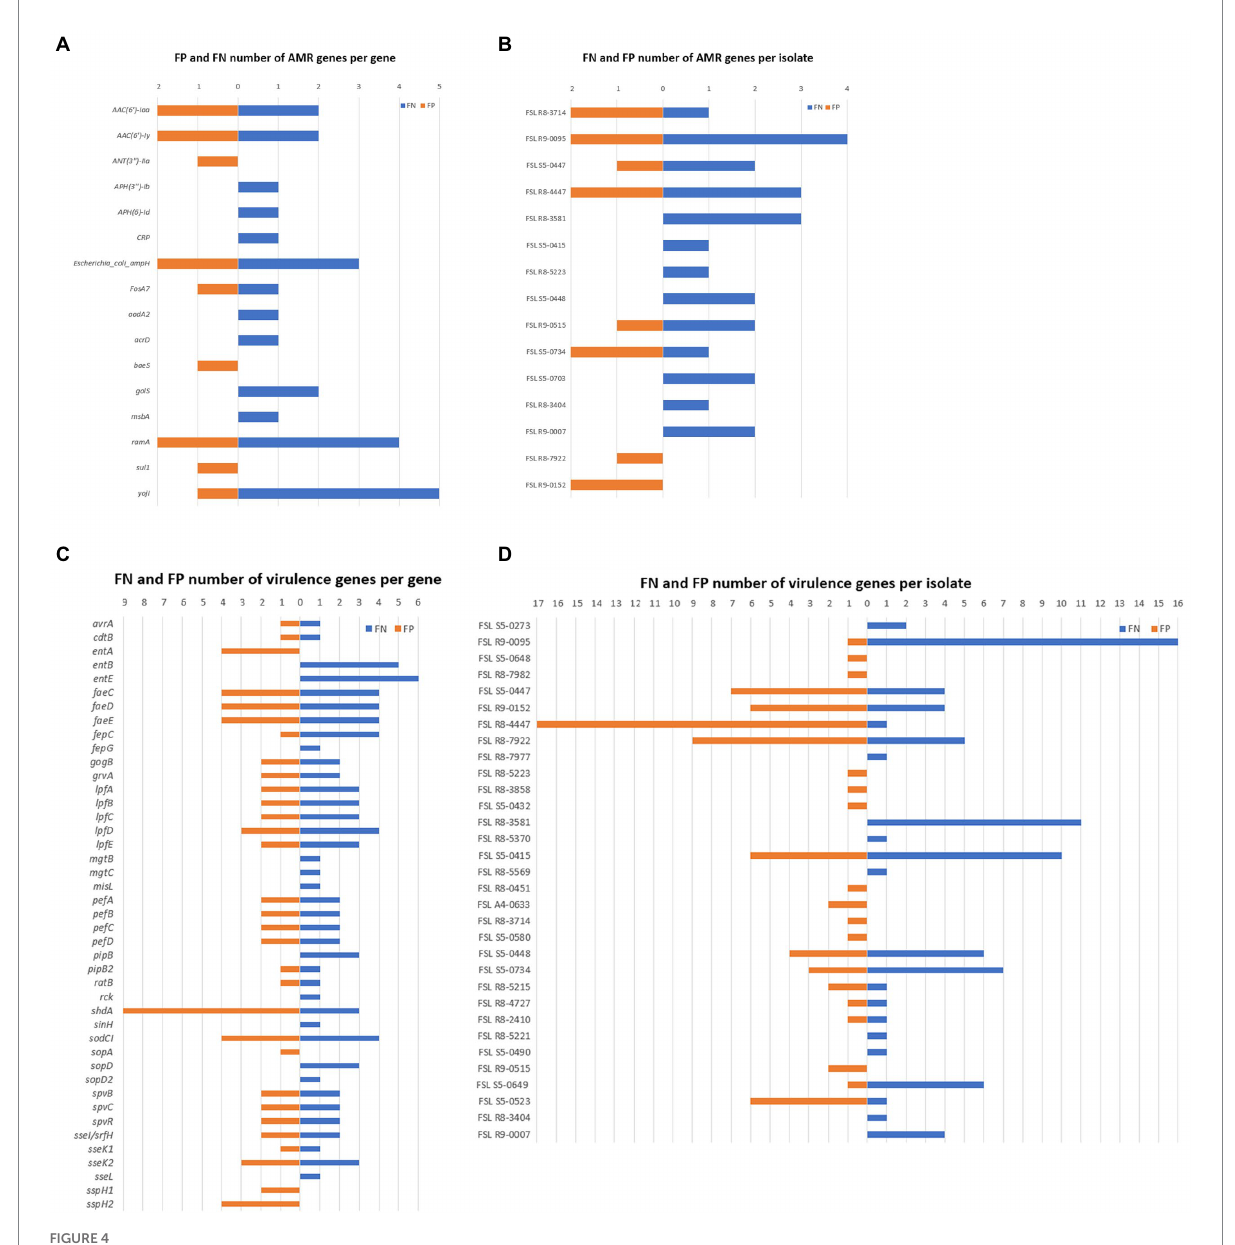
FIGURE 4 False Positive (FP) and False Negative (FN) numbers of AMR and virulence genes detected with ONT data, taking results from Illumina data as benchmark. (A) Number of AMR gene FN (in orange) and FP (in blue) results for different AMR genes; AMR genes not shown did not yield AMR gene FP or FN results; (B) Number of AMR gene FN and FP results for each given isolate; isolates not shown did not yield AMR gene FN or FP results; (C) Number of virulence gene FN and FP results for different virulence genes; virulence genes not shown did not yield virulence gene FP